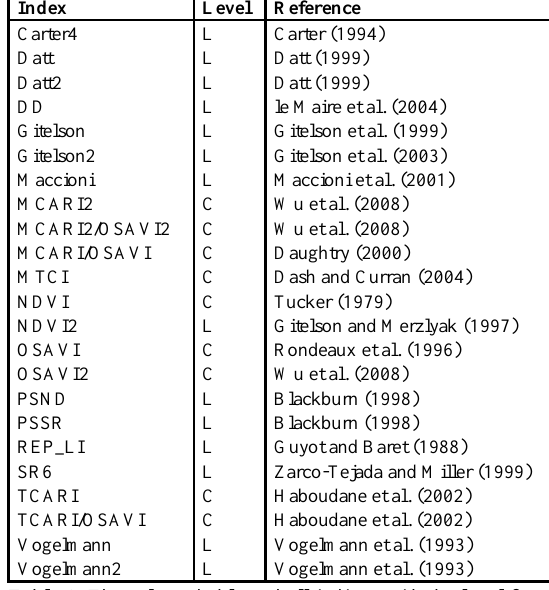
Table 1. The selected chlorophyll indices with the level from which they were retrieved (L = leaf, C = canopy) and the reference. Adapted after Main et al. (2011) and le Maire et al.